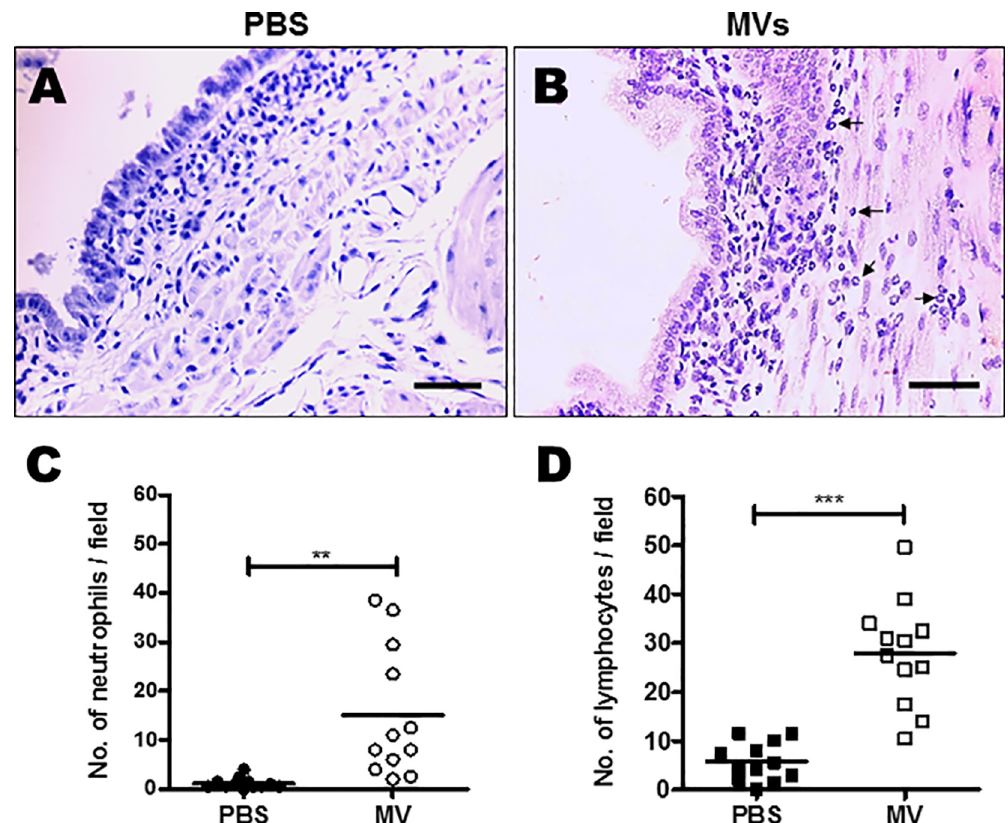
Fig 6. Intra-amniotic GBS membrane vesicles causes chorio-amnionitis. A-B. On E 14.5, each fetus was injected with PBS ( A) or membrane vesicles (MVs) ( B ) in the amniotic sac. 24 h after injections, chorio-decidua were collected. Haematoxylin and eosin stained sections were examined for features of chorio-amnionitis. Arrows in B indicates leukocytes. Scale bar; 200 μ m. C-D. Number of neutrophils ( C ) and lymphocytes ( D ) present in chorio-decidual tissue were enumerated across different fields as described in the methods. Statistical analysis was performed using Students t-test; *** p < 0.001; ** p < 0.005.